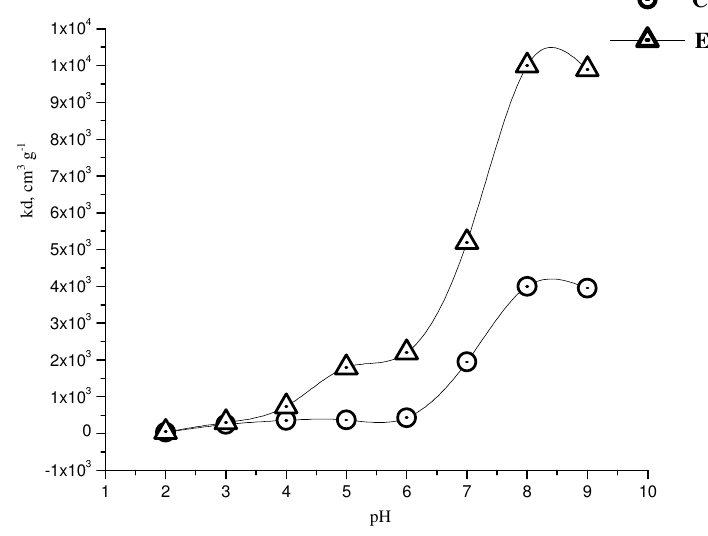
Figure 4. Effect of pH on the sorption of Ce and